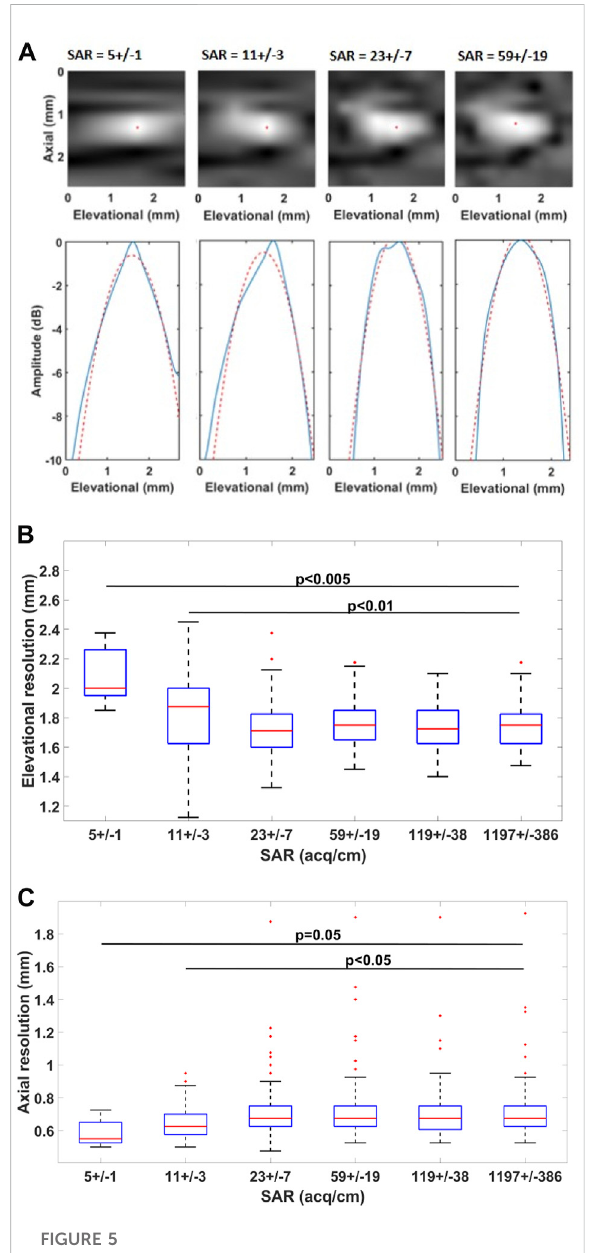
FIGURE 5 Impact of SAR on resolution ( (A) top) Visualized LSF for a certain imaging plane and ( (A) bottom) LSF in the elevational direction. The blue line shows the elevational LSF pro fi le and the red dashed line shows its parabolic approximation. The red dot indicates the maximum of the LSF (B) Boxplot of the estimated resolutions in the elevational and axial (C)